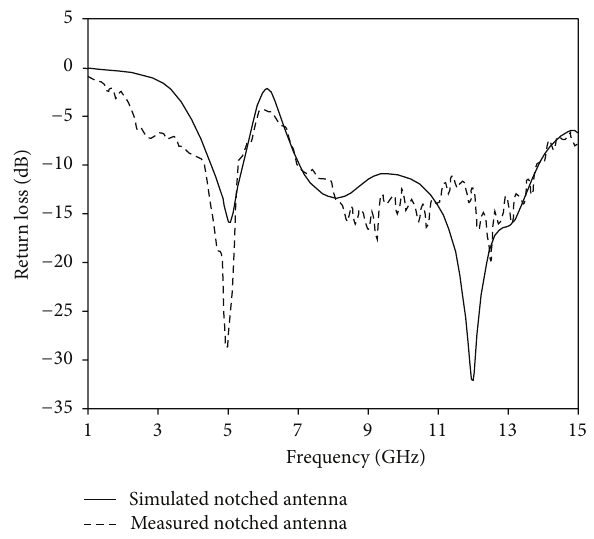
Figure 4: Measured and simulated return loss of the proposed notched